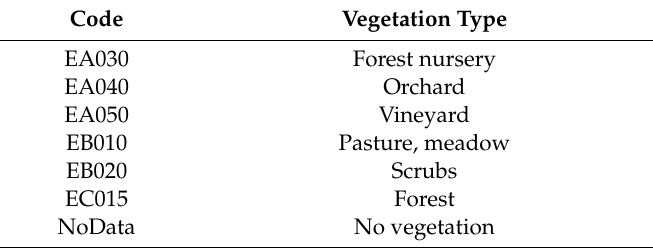
Table 4. Codes of vegetation types [36].